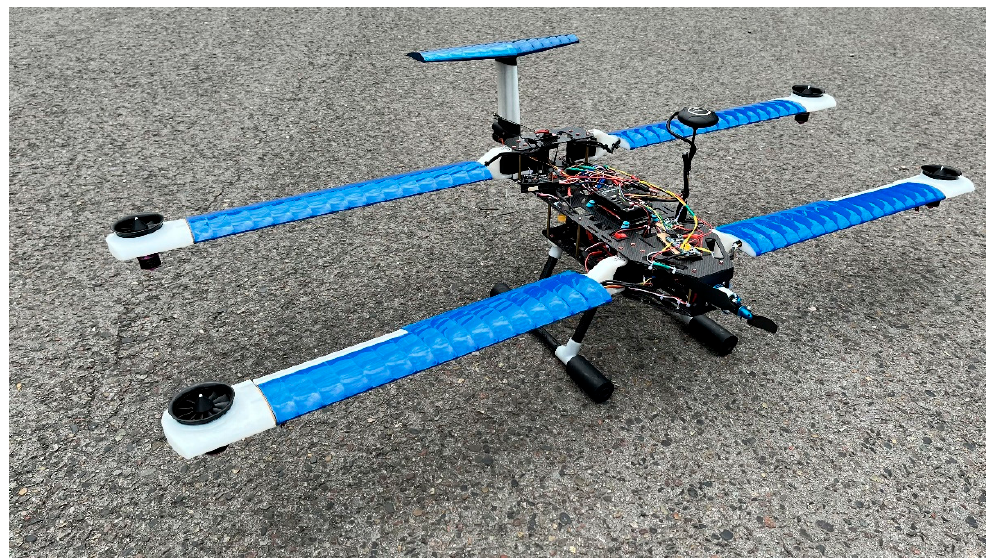
Figure 2. Photos of the aircraft.